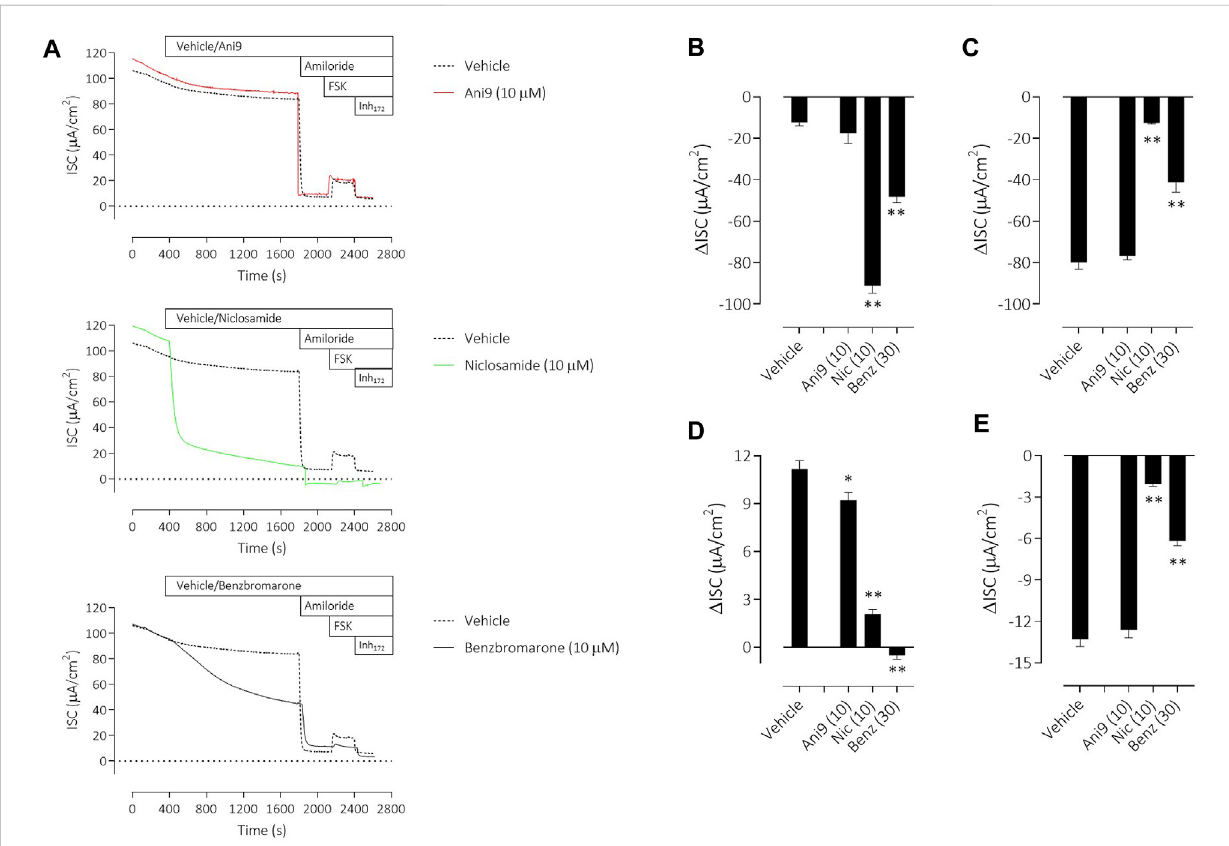
FIGURE 6 Multiple effects of niclosamide and benzbromarone on epithelial ion transport mechanisms in HBE cells. Sample short-circuit current traces (A) illustrating the effects of Ani9, niclosamide (Nic) and benzbromarone (Benz) on the ion transport properties of HBE cells (non-CF). The mean ± SEM changes in baseline (B) , amiloride-sensitive (C) , forskolin-stimulated (D) and Inh172-sensitive (E) ISC responses are shown ( n = 6 inserts per group). Concentrations of test compounds are shown in brackets as µM. * and ** denote p < 0.01 and p < 0.0001 respectively following a one-way ANOVA using post hoc Dunnett ’ s